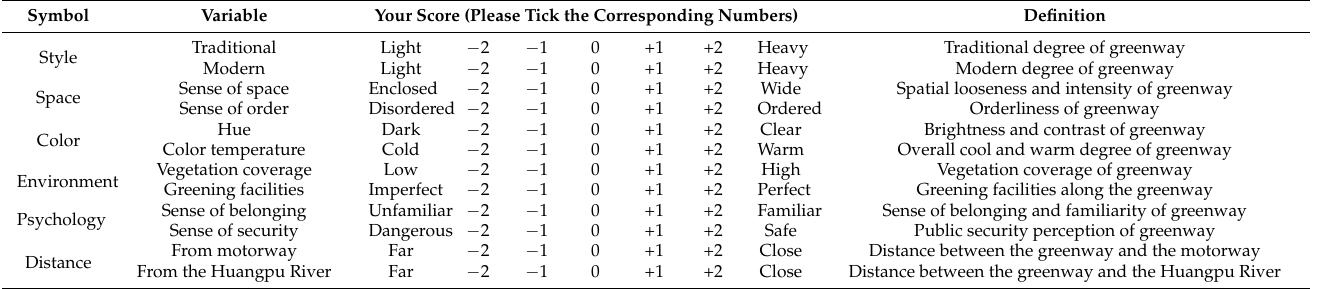
Table A2. How do you rate the elements of Huangpu riverside greenway?